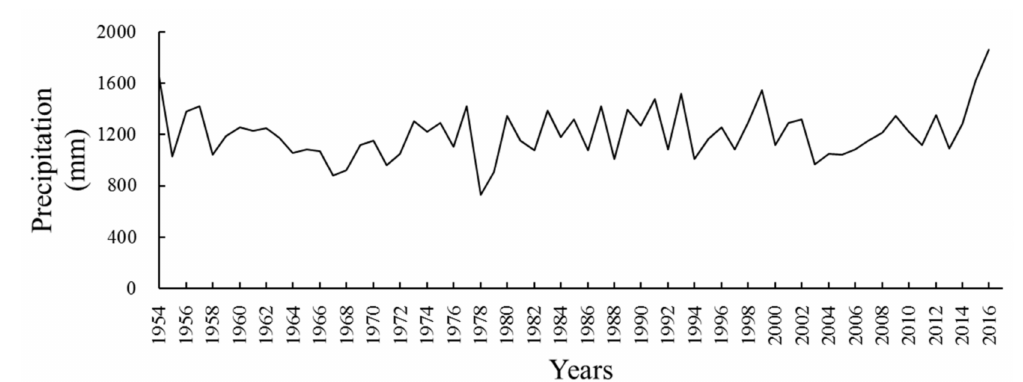
Figure 3. Precipitation in Taihu Lake Basin during